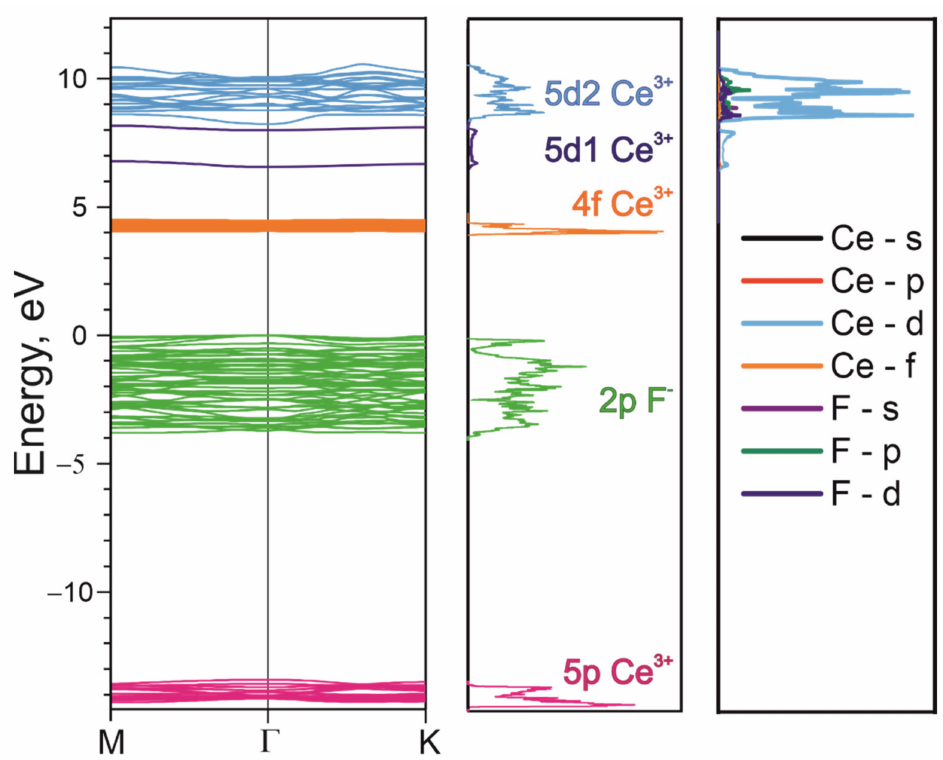
Figure 1. A fragment of ab initio electronic structure calculations of CeF 3 by the PAW method. The total density of electronic states is given in the center. The partial density of electronic states is given on the right-hand side.